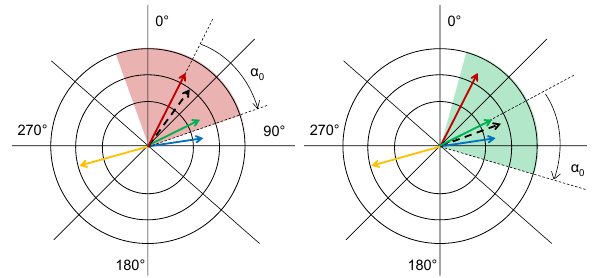
Figure 2. Angular displacements and weighted average velocities (see text for details).